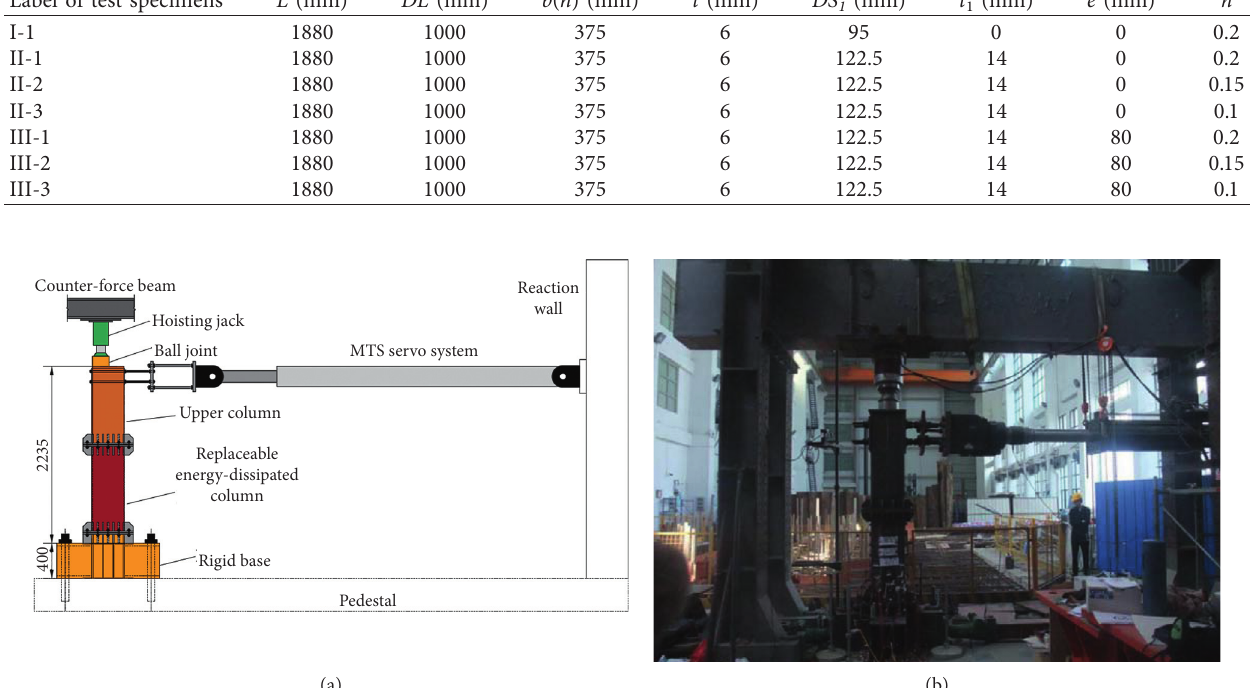
Figure 2: Loading system and photo of onsite loading. (a) Design of the loading system (unit: mm). (b) Photo of onsite loading.